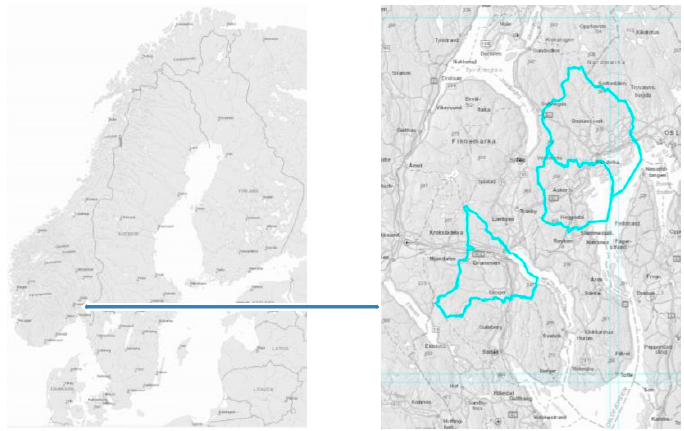
Figure 1. Map of the Nordic countries and a zoom-in of Asker, Bærum, and Drammen municipalities [10]. Table 2. Norwegian, Danish, and Swedish plants included in the I/I-water analysis performed on the